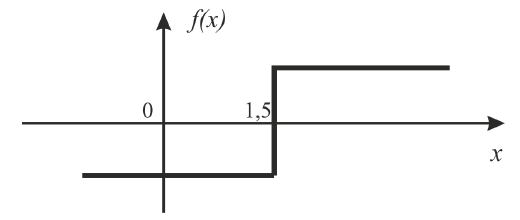
Figure 3: Threshold function as activation function of a neuron, f ( y ) = 1, y ≥ 0;; −1, y <